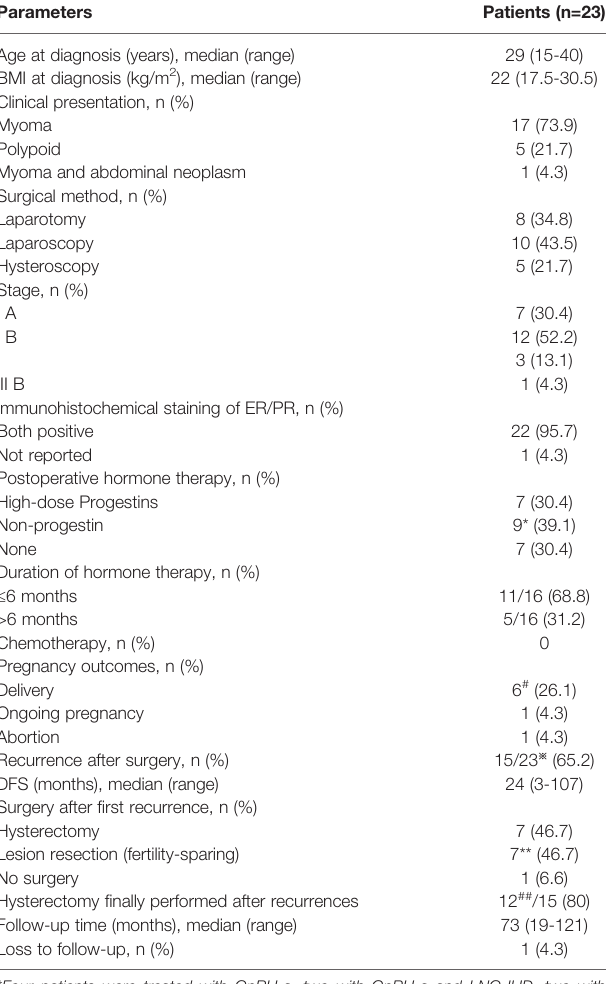
TABLE 4 | Epidemiological characteristics, treatment, and follow-up of the fertility-sparing cohort. Parameters Patients